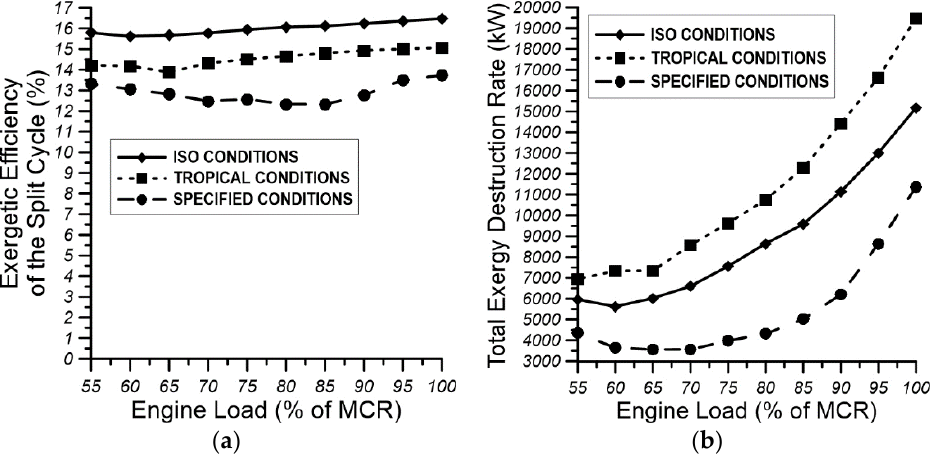
Figure 11. Variation of ( a ) exergy efficiency of the split supercritical cycle, ( b ) total exergy destruction rate of the split supercritical cycle for ISO, tropical, and specified conditions.